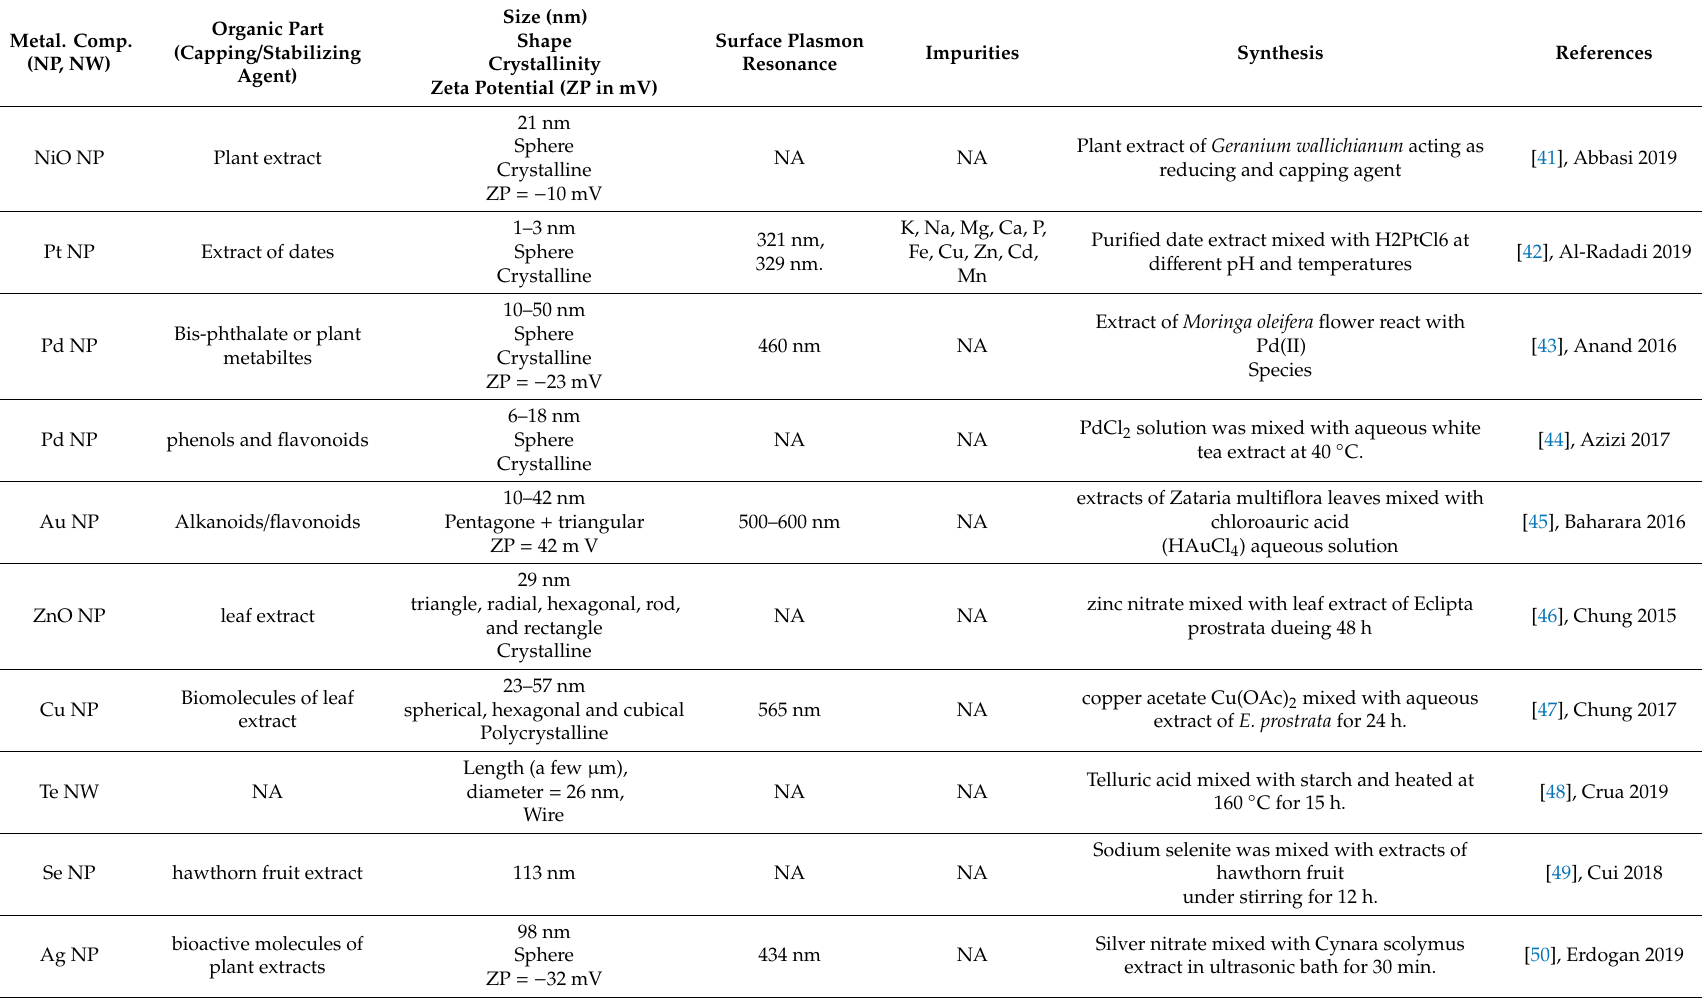
Table 1. Properties of di ff erent types of natural metallic nanoparticles, including the metallic composition, the organic part, the size, the shape, the crystallinity, the zeta potential, the presence (or not) of impurities, and the synthesis